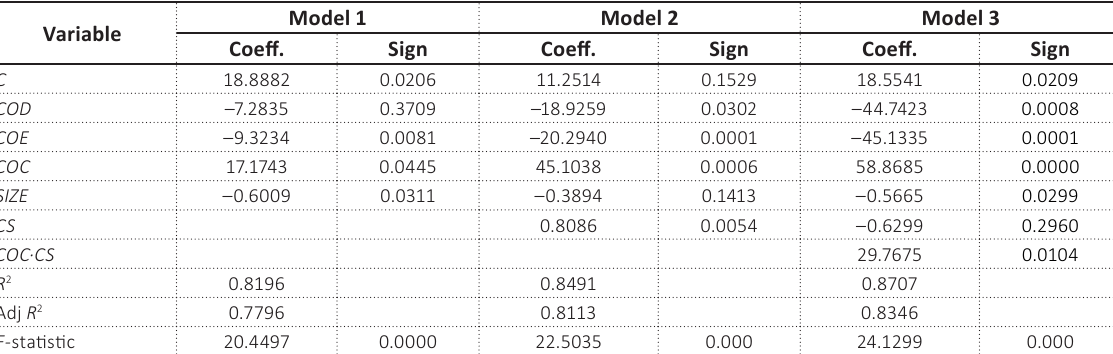
Table 2. Effect of COD, COE, COC on PBV of Pulp & Paper companies, moderated CS and controlled firm size (Fixed effect